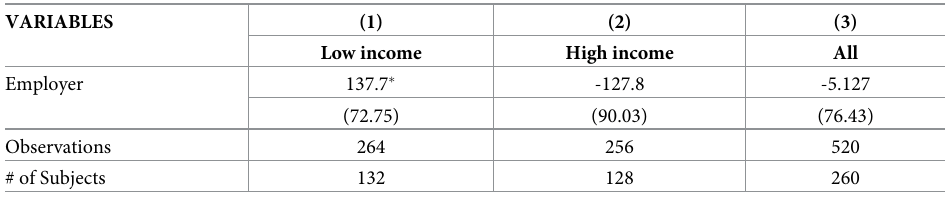
Table 4. Coefficient estimates from regressing cumulative joy on insurance